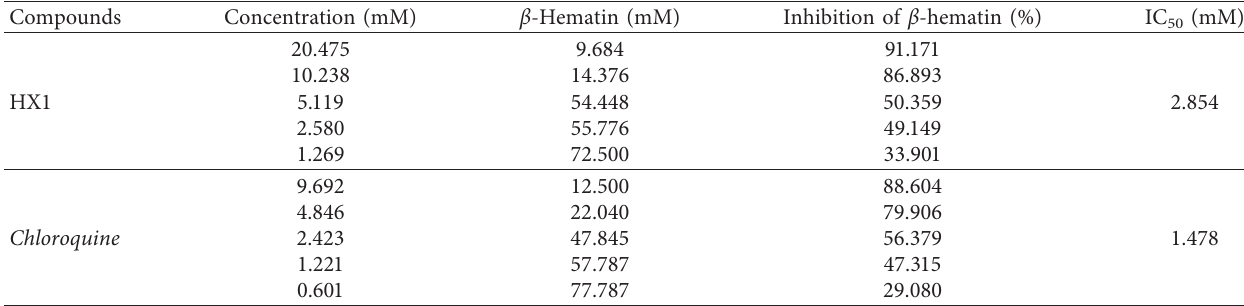
Table 3: The IC 50 value of 1,6,8-trihydroxyxanthone (HX1) compound and chloroquine on the formation of the β -hematin using method of HPIA.